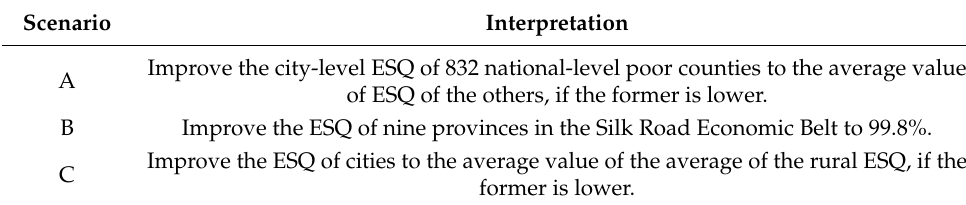
Table 6. Scenario-based design of ESQ